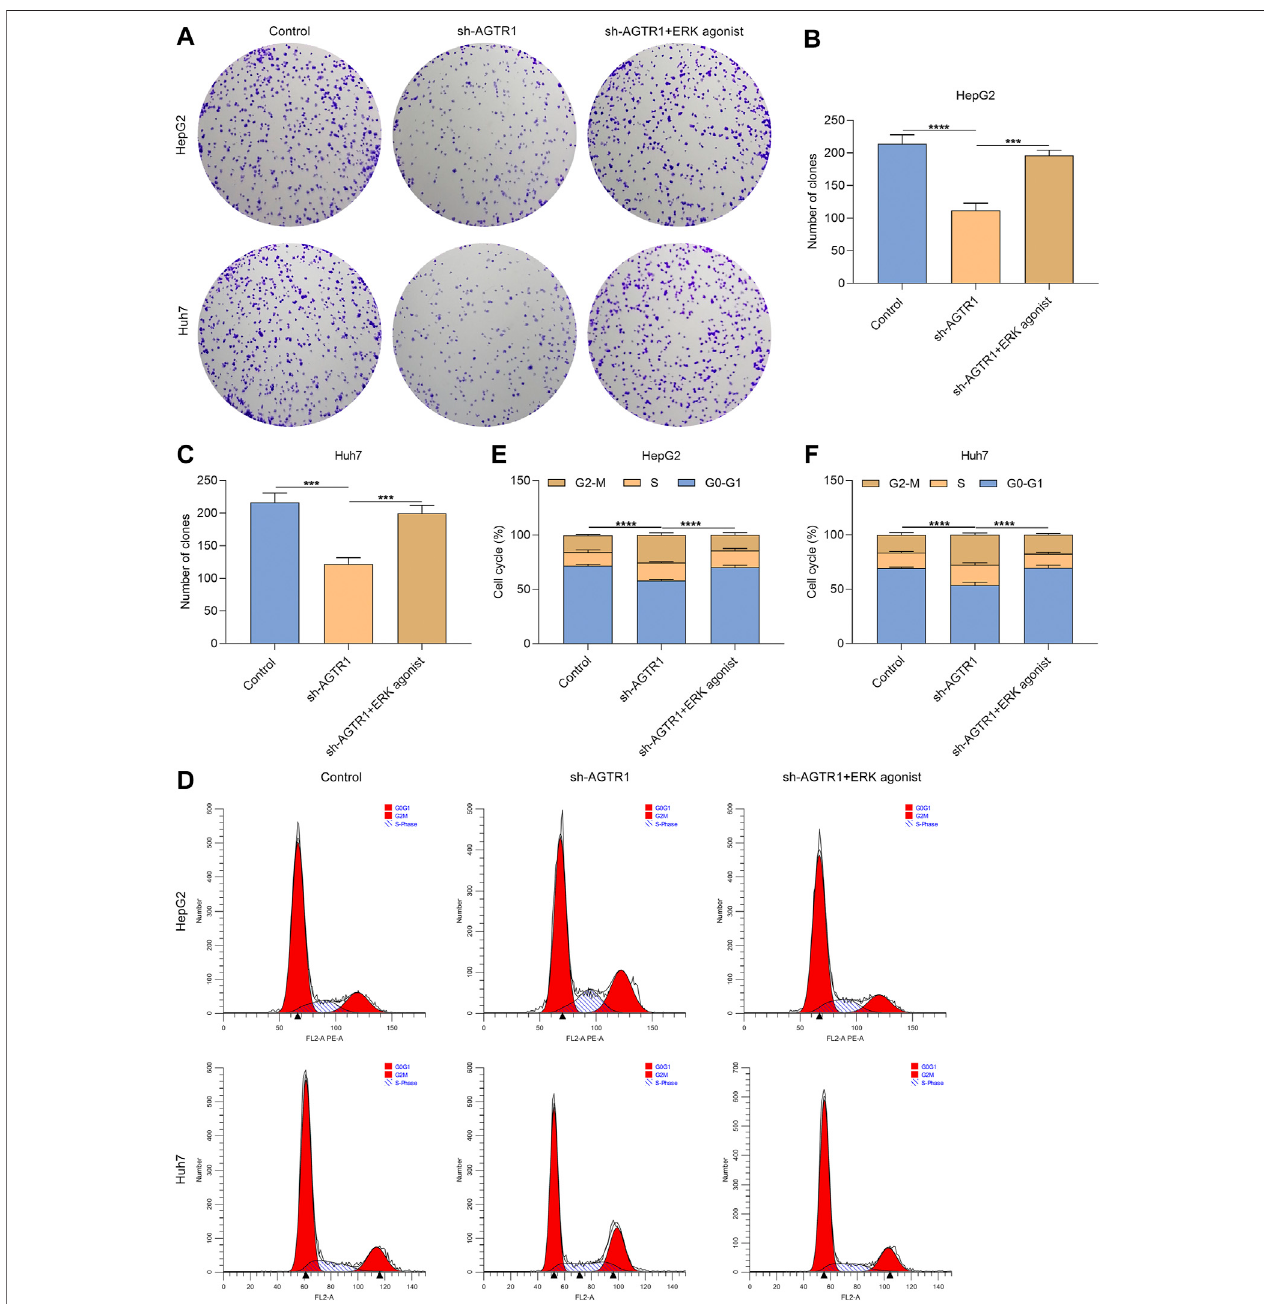
FIGURE6 | AGTR1knockdown suppresses proliferationand triggers growth arrest for HCC cells through inactivating ERK signaling. (A – C) Numberof colonies of HepG2 and Huh7 cell lines with sh-AGTR1 lentivirus transduction or ERK agonist EGF. (D – F) Cell cycle of HCC cell lines with sh-AGTR1 lentivirus transduction or ERK agonist